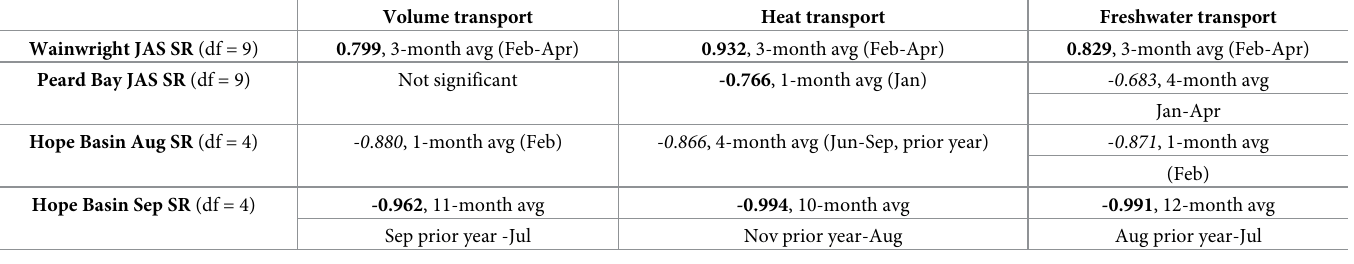
Table 3. Coefficients of linear correlation between 1 to 12- month time-averaged transport at mooring A3 (Woodgate 2018) and gray whale July-August-September (JAS) sighting rates